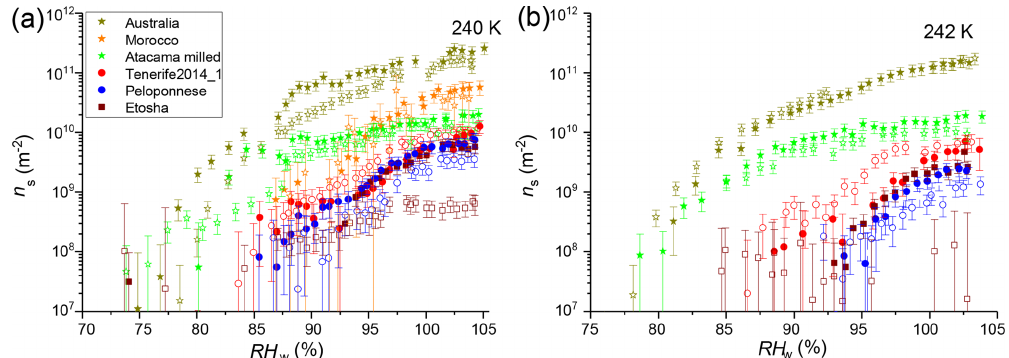
Figure 3. Ice-active surface site density at (a) 240K and (b) 242K of samples before (filled symbols) and after (open symbols) heat treatment. Error bars include the Poisson error of the INP measurements and the maximum variation of A ve , w . Square symbols indicate surface-collected samples, stars indicate milled samples, and circles indicate airborne samples.